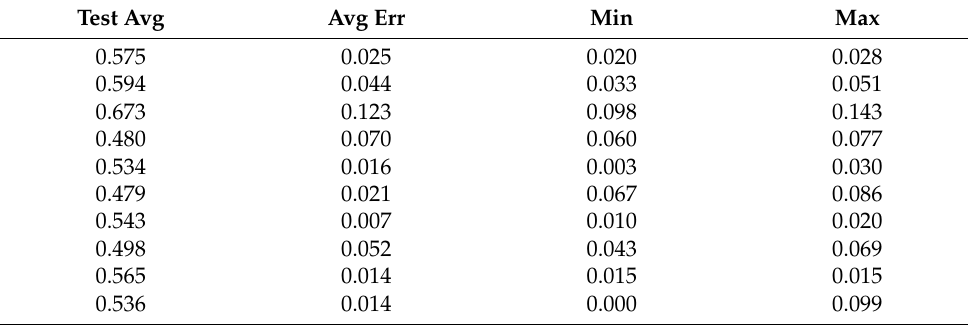
Table A147. Set 2, trials 41–50 data (all 0.5 PR values).